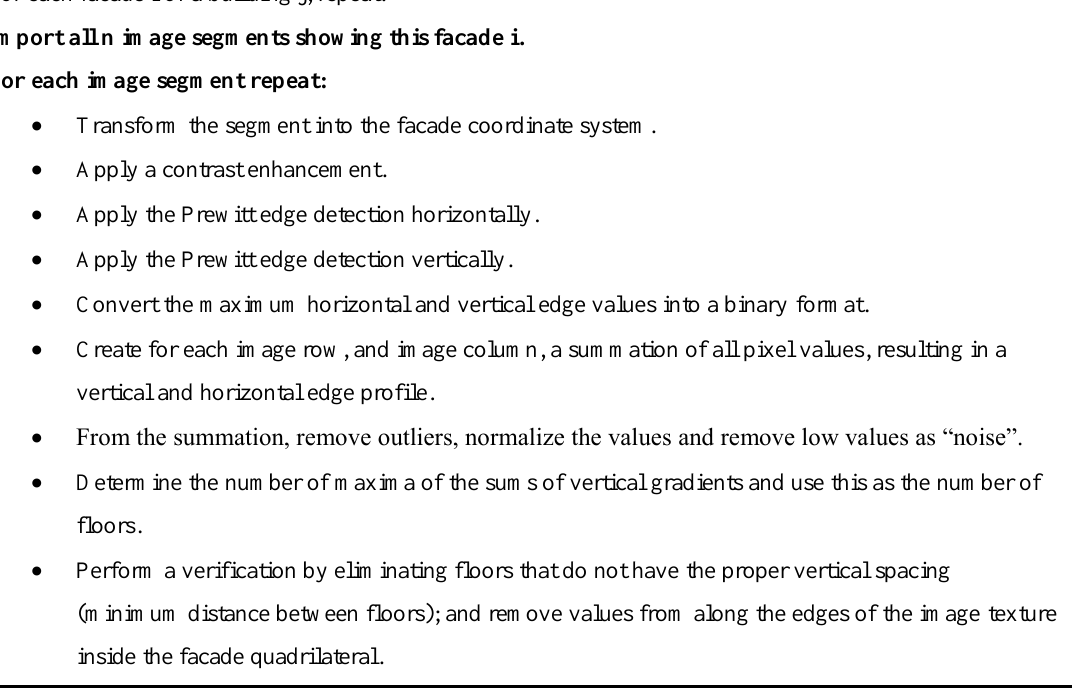
Table 2. Procedure for floor detection in simple planar